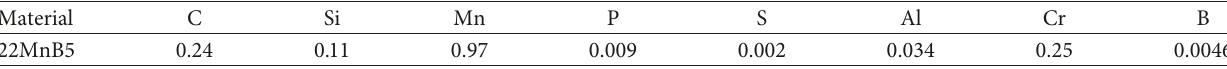
Table 1: Chemical composition of 22MnB5 (wt.%).